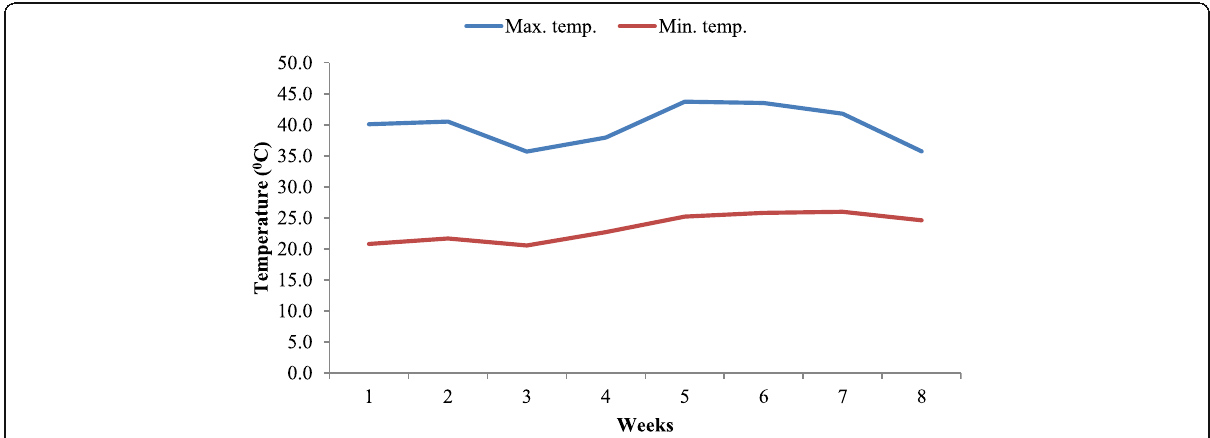
Fig. 1 Maximum and minimum temperature during the experimental period (3.5, 2019-16.6,